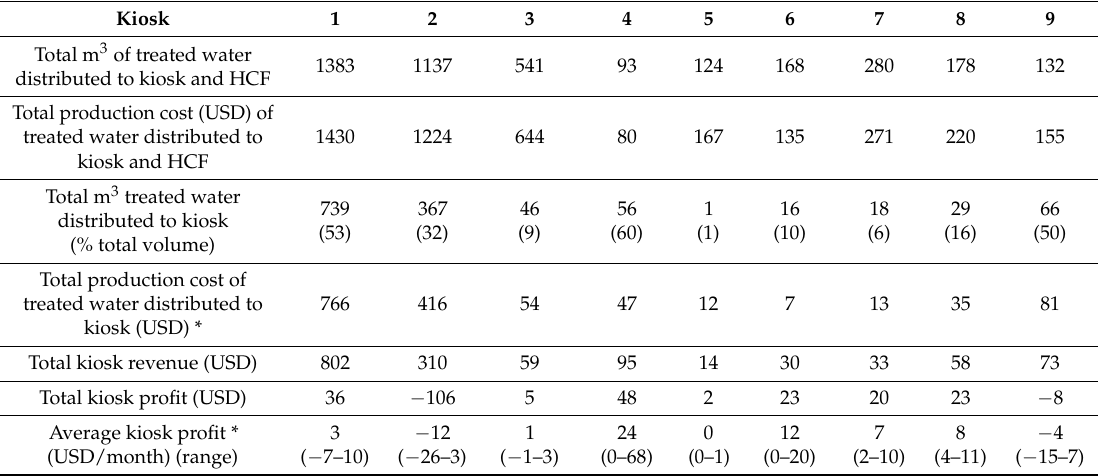
Figure 2. Monthly Profits and Losses of Nine Water Kiosks at Health Care Facilities in Rural Rwanda, 2013–2014. Table 4. Total Production Volumes, Kiosk Profits, and Costs of Water Treatment for Nine Health Care Facilities and Water Kiosks in Rural Rwanda,